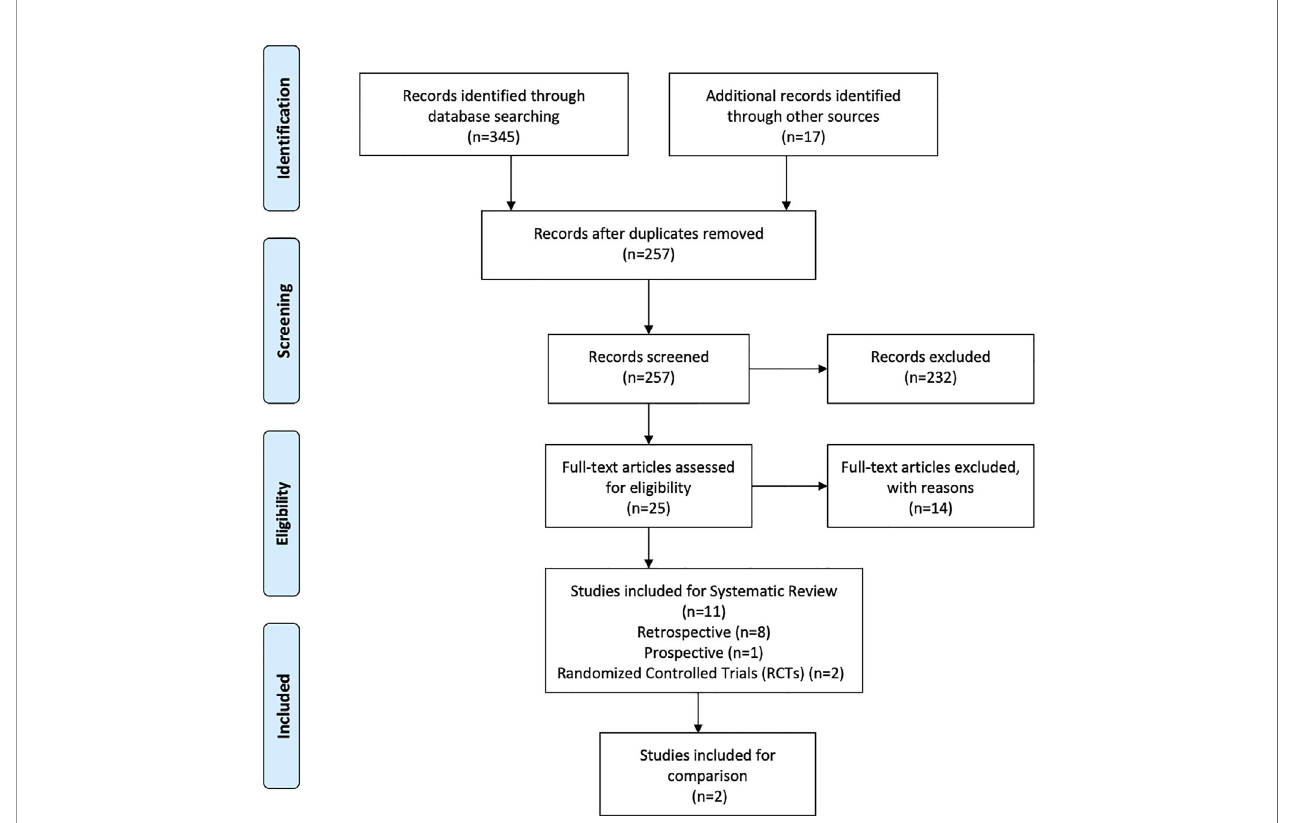
FIGURE 1 | PRISMA fl ow diagram of research strategy and study